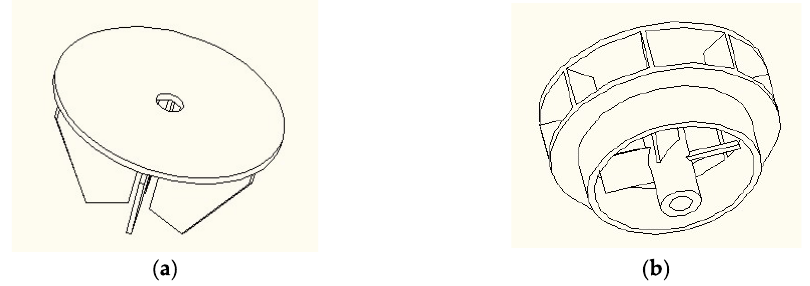
Figure 2. Schematic diagram of the defoaming impeller. ( a ) Impeller DC, ( b ) Impeller